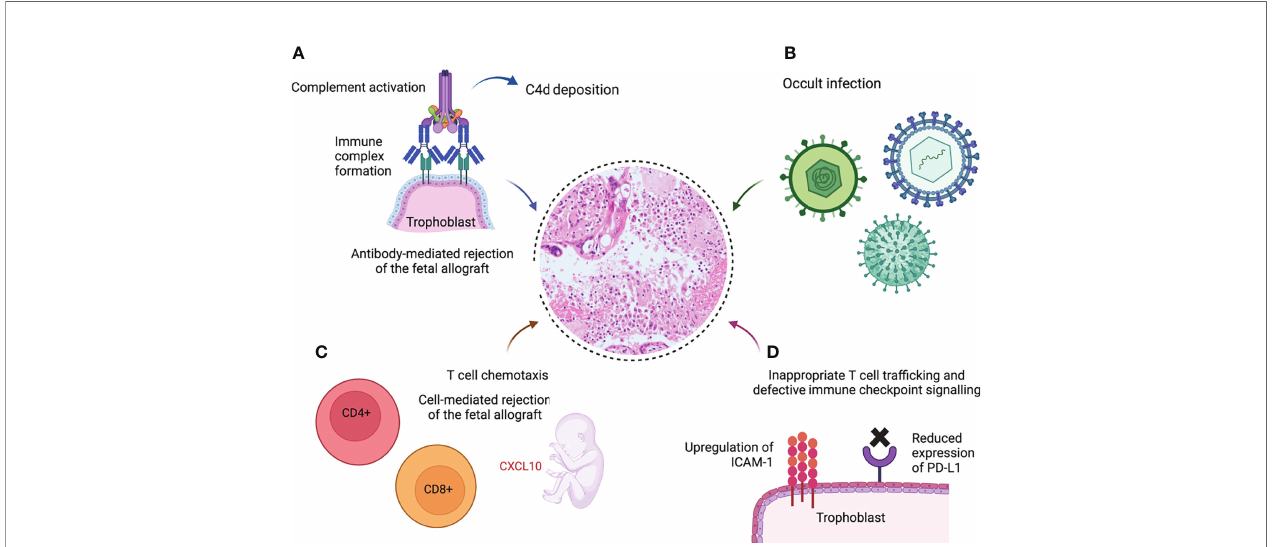
FIGURE 3 | Schematic demonstrating potential pathological pathways leading to villitis of unknown etiology (VUE) (9, 86, 107, 108, 159, 160). (A) Formation of immune complexes at the syncytiotrophoblast leads to complement activation and C4d deposition. (B) Undiagnosed infection is responsible for the chronic in fl ammation. (C) The fetal response to maternal in fi ltration of the villi includes elevated plasma levels of the T cell chemokine CXCL10, a hallmark of solid organ allograft rejection (8). (D) Excessive intercellular adhesion molecule-1 (ICAM-1) expression on the syncytiotrophoblast in VUE promotes in fi ltration of maternal T cells (159); programmed death ligand-1 (PD-L1), which suppresses cytotoxic T cell activity, is downregulated in VUE (160). Created with